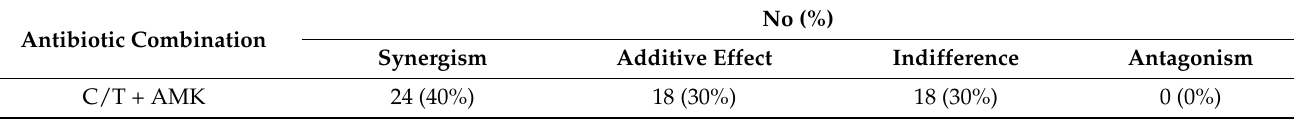
Table 3. In vitro synergistic testing of ceftolozane/tazobactam (C/T) with amikacin against CRPA isolates ( n =